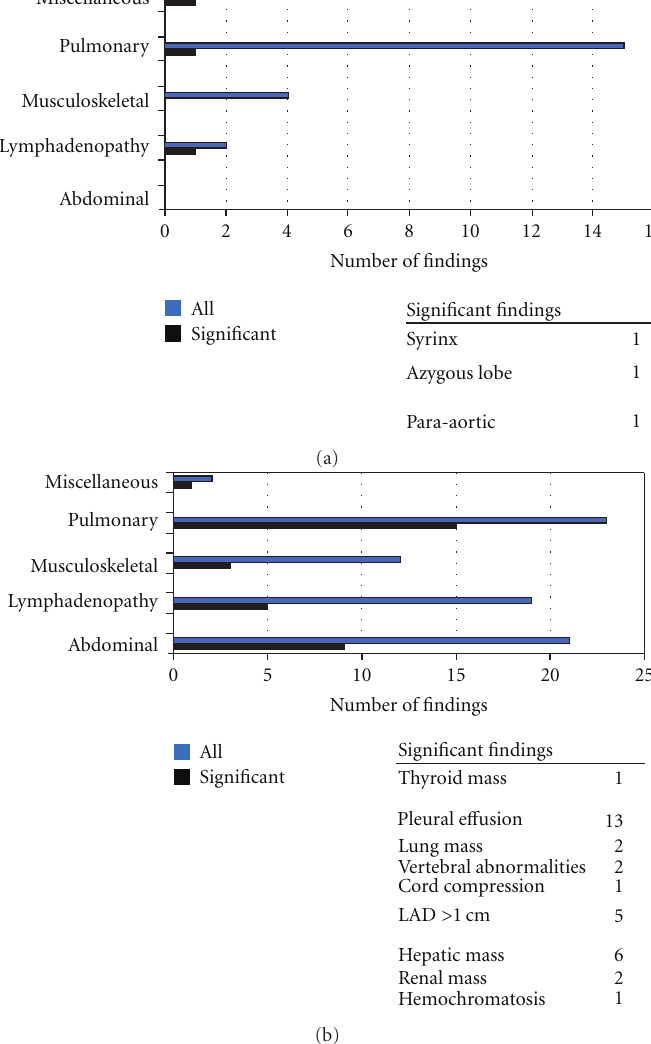
ative changes of the spine ( n =